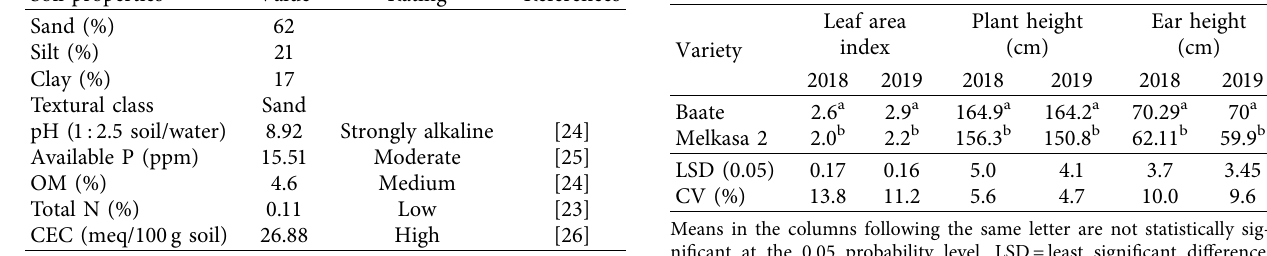
Table 5: Mean values of leaf area index, plant height, and ear heights as affected by the main effect of variety in the 2018 and 2019 cropping seasons.